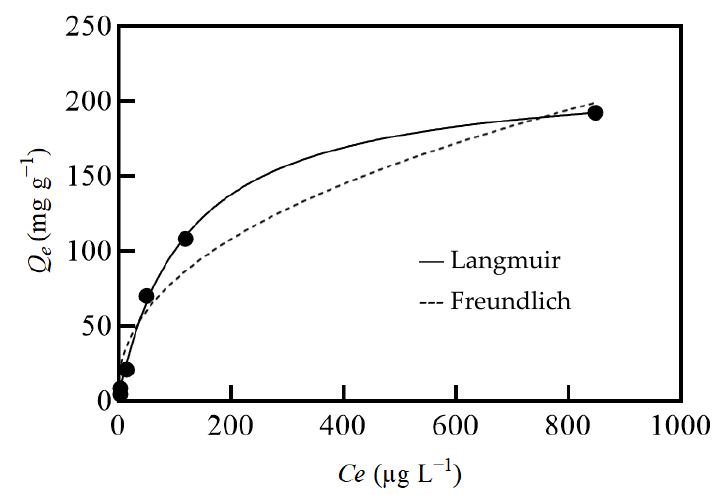
Figure 3. The Langmuir (straight line) and Freundlich (dotted line) isotherm models applied to the experimental data (dots) of Hg(II) sorption on rGO/PEI at different metal concentrations.